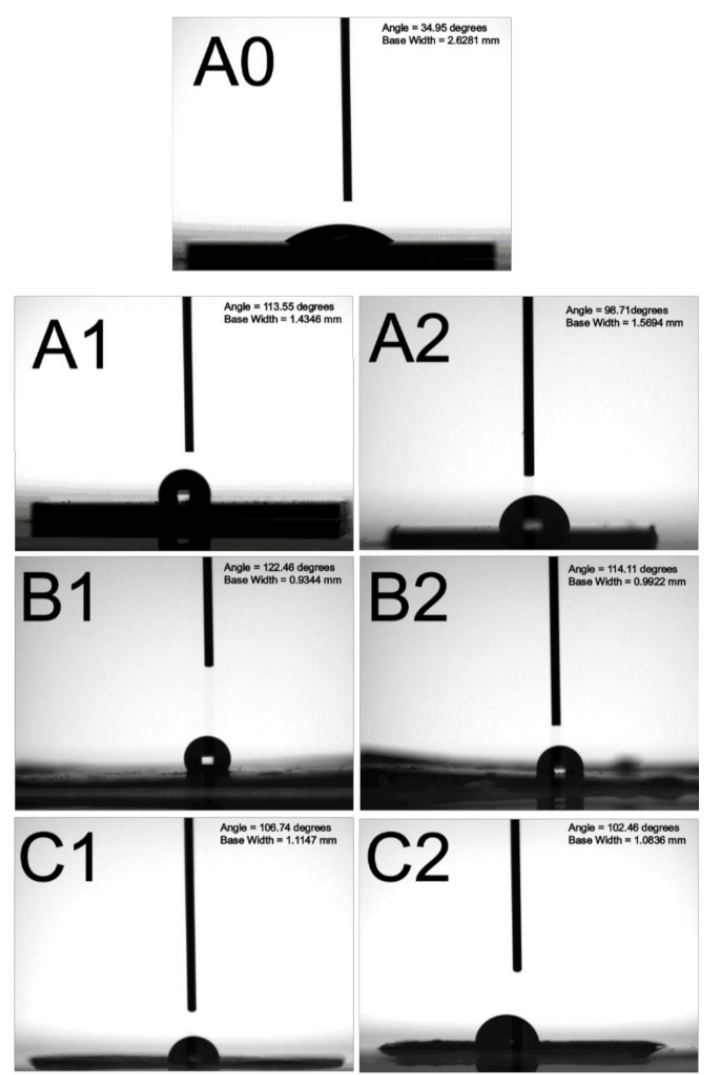
Figure 13. Water contact angles of ( A0 ) silicon substrate—34.95 ◦ , ( A1 ) assembled 300 nm nanosphere array—113.55 ◦ , ( A2 ) assembled 900 nm nanosphere array—78.56 ◦ , ( B1 ) replicated 300 nm soft mold—122.46 ◦ , ( B2 ) replicated 900 nm soft mold—114.11 ◦ , ( C1 ) embossed 300 nm featured film—106.74 ◦ , ( C2 ) embossed 900 nm featured film—102.46 ◦